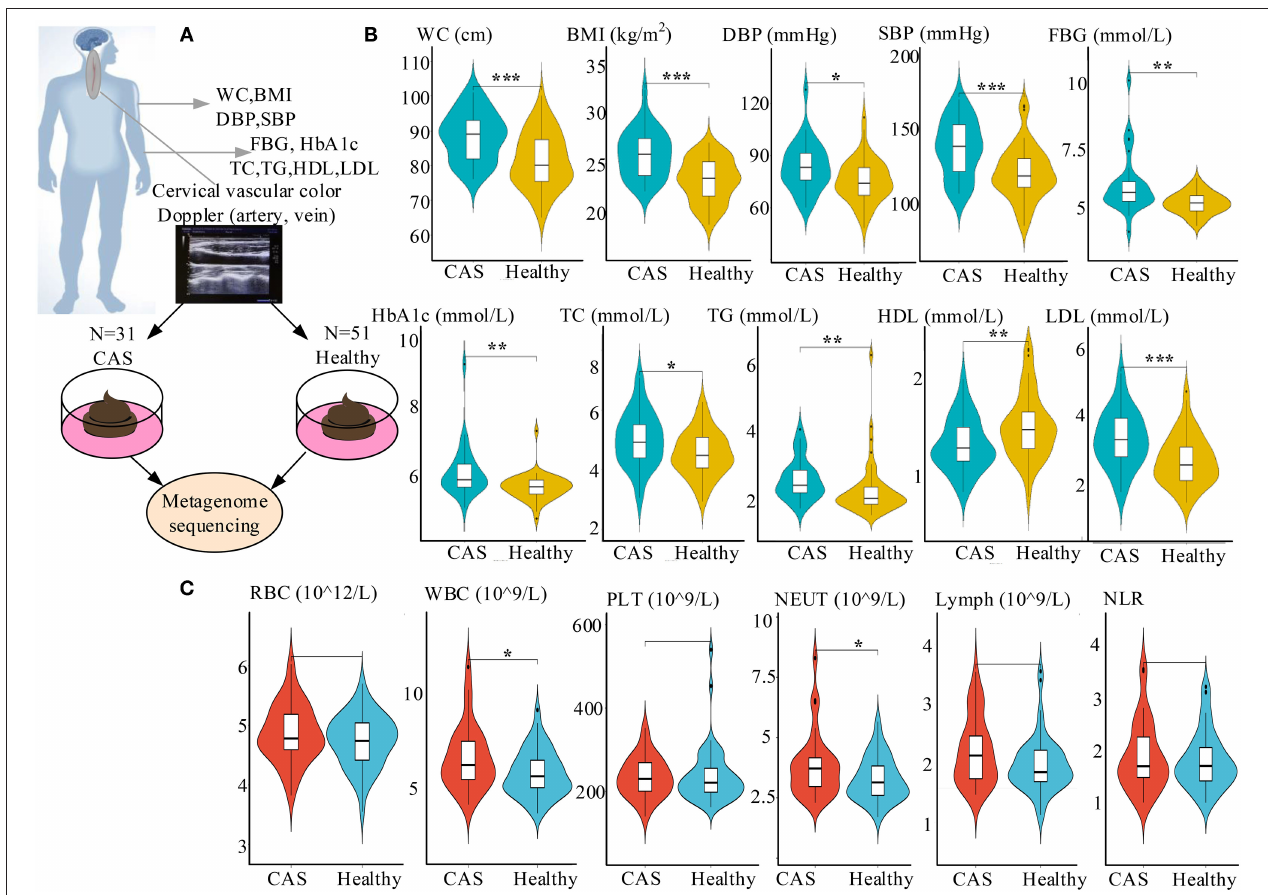
FIGURE 1 | Study design and characteristics of the clinical parameters. (A) Study design including the cross-sectional cohort. (B) Comparisons of risk factors between the CAS and healthy control groups. (C) Comparisons of inflammatory markers between the CAS and healthy control groups. *, **, and *** denote p < 0.05, p < 0.01, and p < 0.001 compared with healthy controls, respectively. CAS, carotid arteriosclerosis; WC, waist circumference; BMI, body mass index; DBP, diastolic blood pressure; SBP, systolic blood pressure; FBG, fasting blood glucose; HbA1c, glycated hemoglobin A1c; TC, total cholesterol; TG, triglyceride; HDL-C, high-density lipoprotein cholesterol; LDL-C, low-density lipoprotein cholesterol; SUA, serum uric acid; RBC, red blood cell; WBC, white blood cell; PLT, platelets; NEUT, absolute value of neutrophils; Lymph, absolute value of lymphocytes; NLR, neutrophil-to-lymphocyte